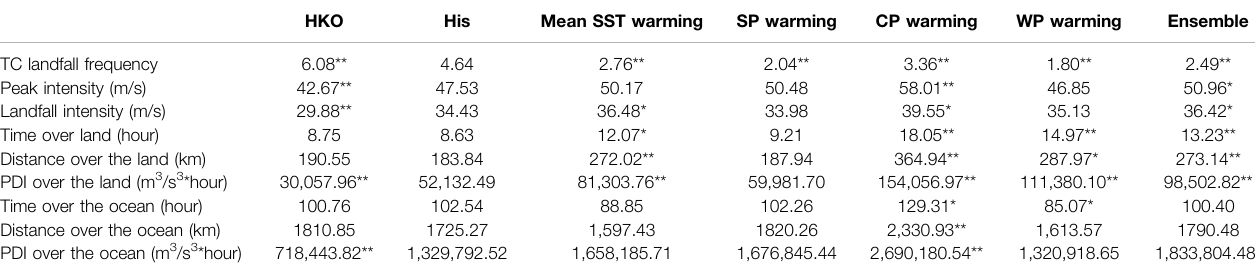
Stars indicates values that passed Student ’ s t test compared with MRI-AGCMs present-day (His.) runs (* indicates 0.1 signi fi cance level; ** indicates 0.05 signi fi cance